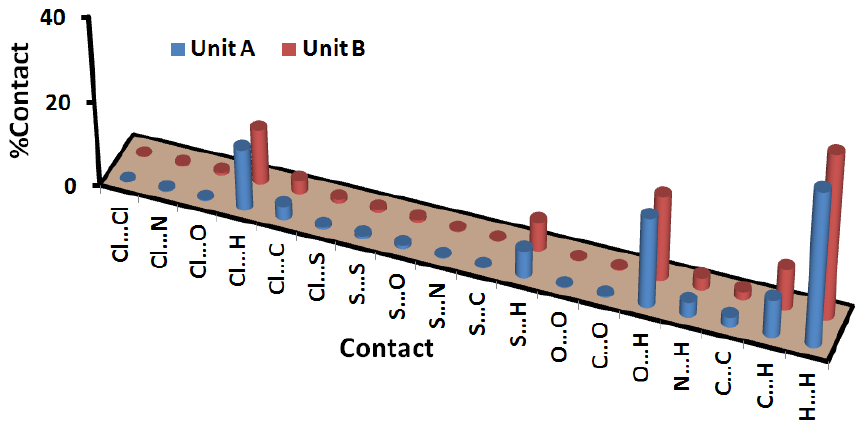
Figure 5. The percentages of all possible intermolecular interactions in the crystal structure of 5a .